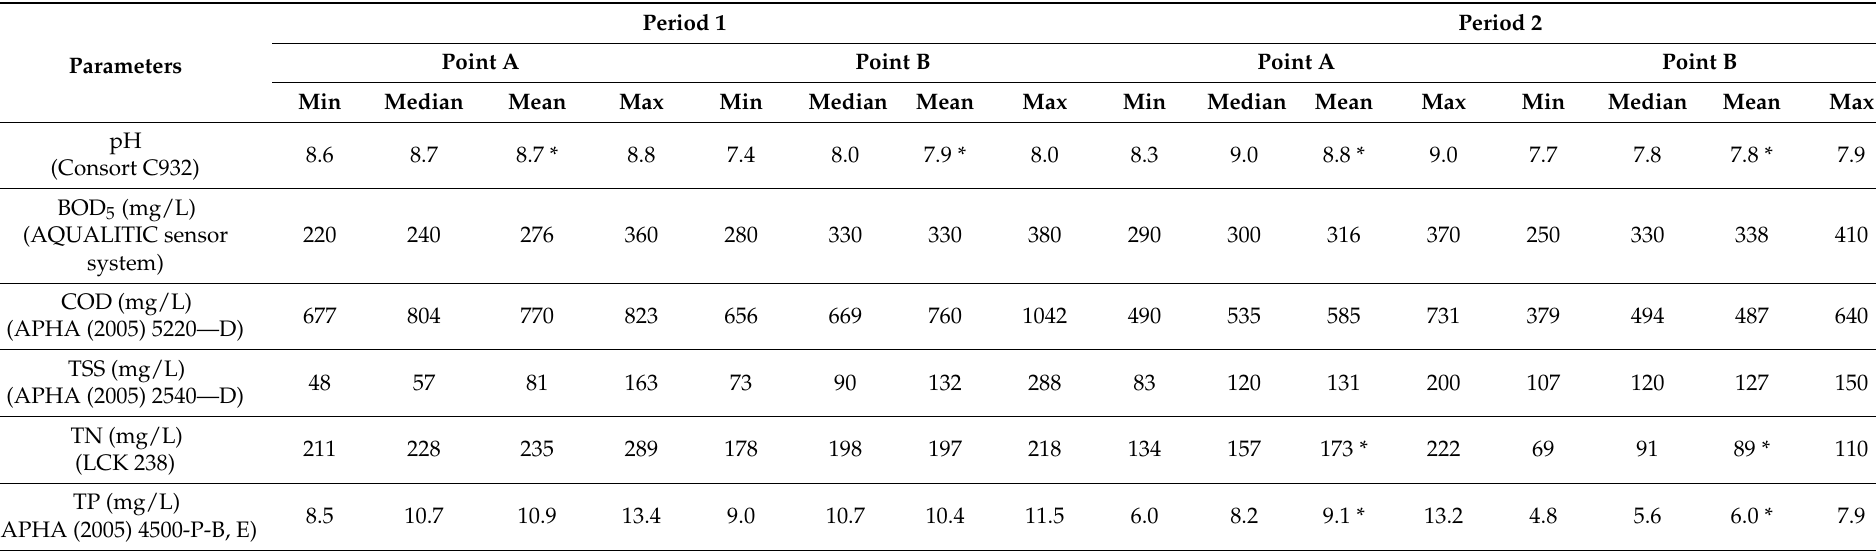
Table 1. Conventional physico-chemical parameters measured in HWW of Point A and Point B during two different sampling campaigns.